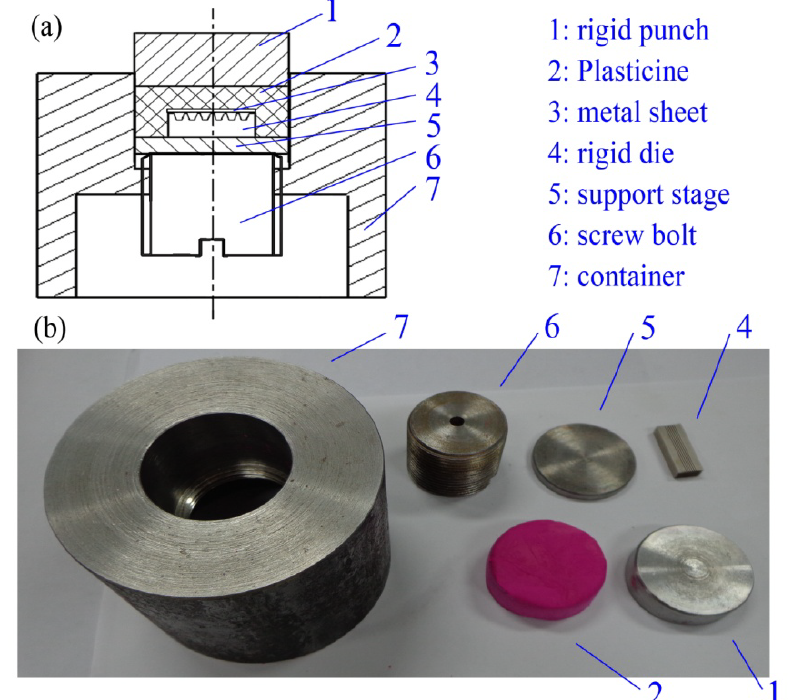
Figure 1. Experiment setup of the micro sheet stamping process using plasticine as soft